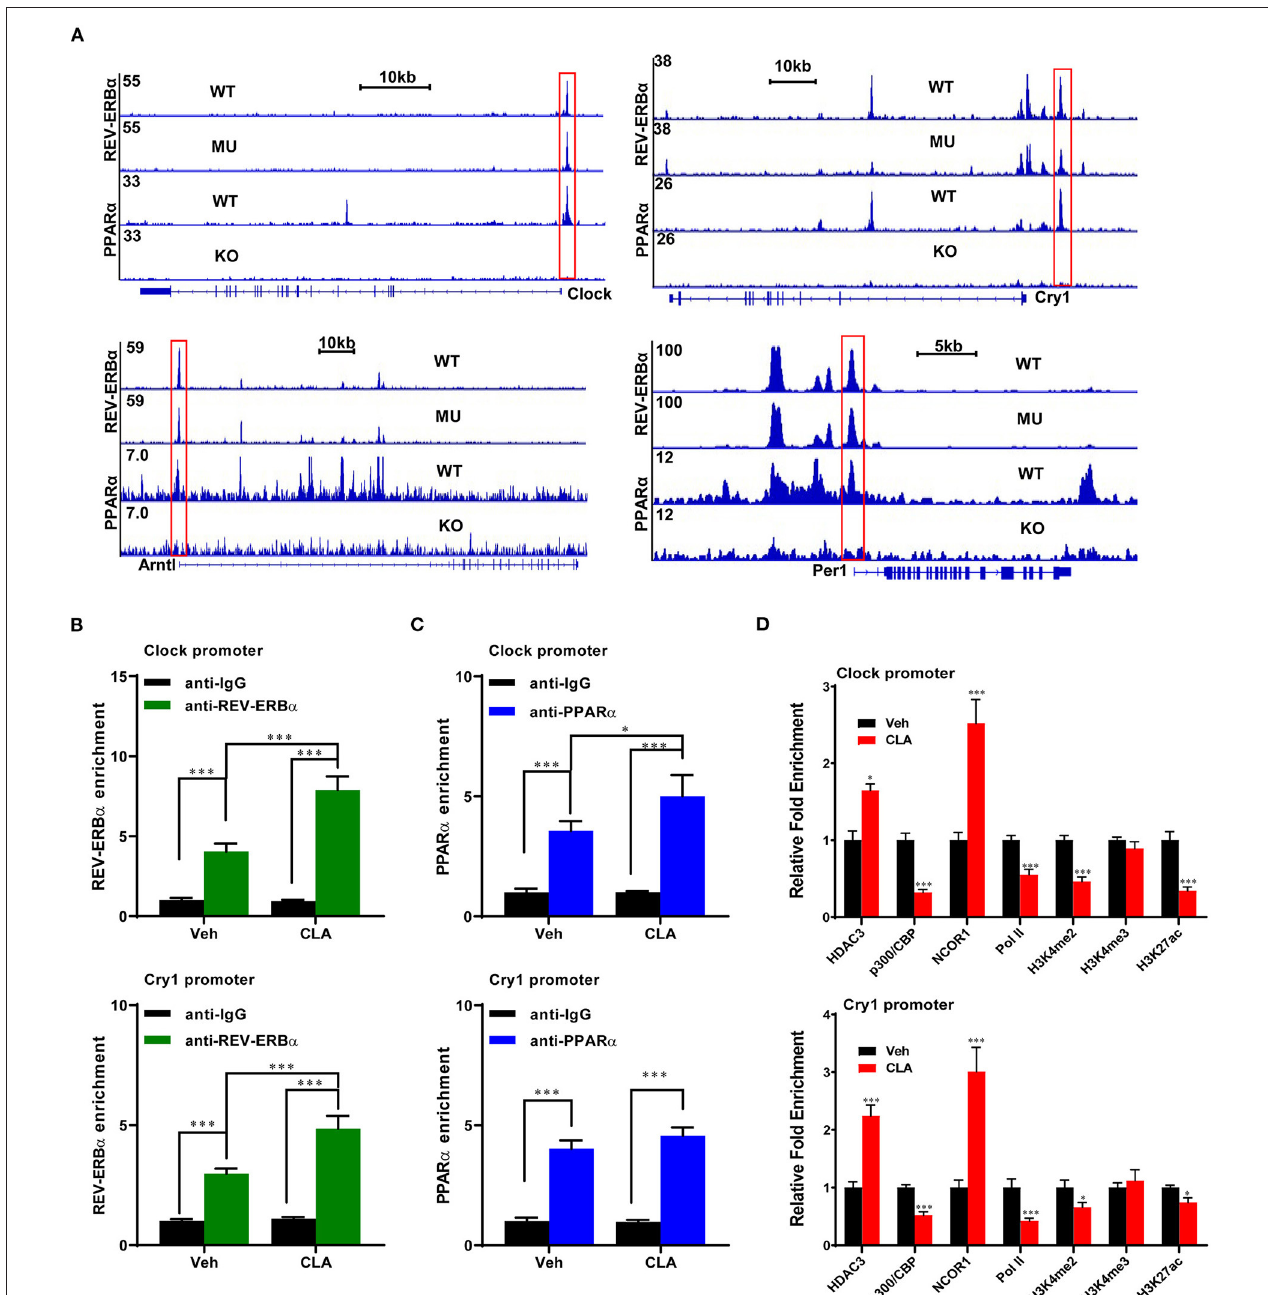
FIGURE 4 | REV-ERB α recruits histone repressors on the circadian genes in the CLA-treated murine hepatocytes. (A) Analysis of ChIP-seq dataset in mouse models and ChIP-seq signal visualization of REV-ERB α and PPAR α binding at the clock genes, Clock , Cry1 , Per1. and Arntl. (B,C) REV-ERB α or PPAR α binding to the promoters of Clock (upper panel) and Cry1 (lower panel) determined by ChIP-qPCR in the CLA-treated murine hepatocytes compared to Veh. (D) Relative enrichment of cofactors HDAC3, p300, and NCOR1, Pol-II, and histone mark H3K4me2, H3K4me3, and H3K27ac. The data are shown as the means ± SD, n = 6 per group. The experiments were repeated three times. * p < 0.05, *** p < 0.001, using the two-tailed student’s t -test or ANOVA with Tukey’s post hoc test. the results suggest that in CLA-treated hepatocytes, the our results showed that the PPAR α antagonist quenched PPAR α plays a dominant role in directing the REV-ERB α the activation of the transcription repressor, REV-ERB α by expression via the recruitment of histone marks and cofactors blocking the PPAR α binding to its gene and the associated ( Figures 7A,B local histone modification induced by the CLA. Therefore,